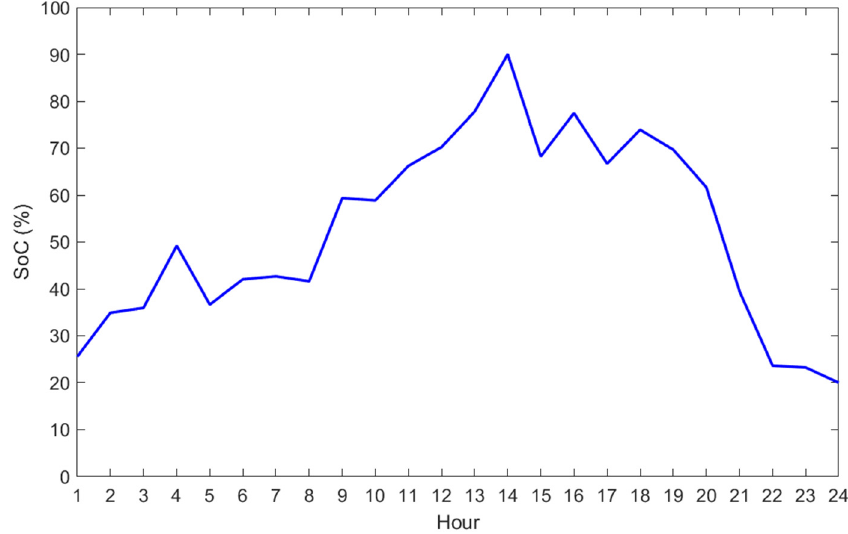
Figure 10. The SoC of ESS after solving the optimal scheduling of ESS by the DE algorithm for case 2.